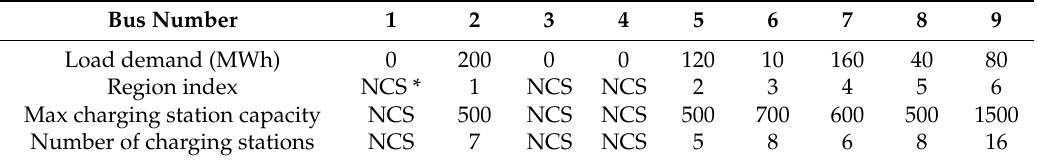
Table 2. Load demand and maximum capacity of electric vehicle charging stations at each bus.